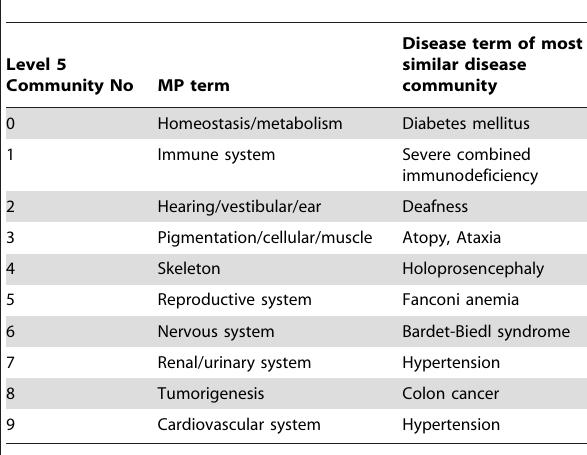
Table 2. Relationship between Level 1 phenotype terms associated with gene communities in the Level 5 network and the disease term associate with the most strongly overlapping disease gene network.